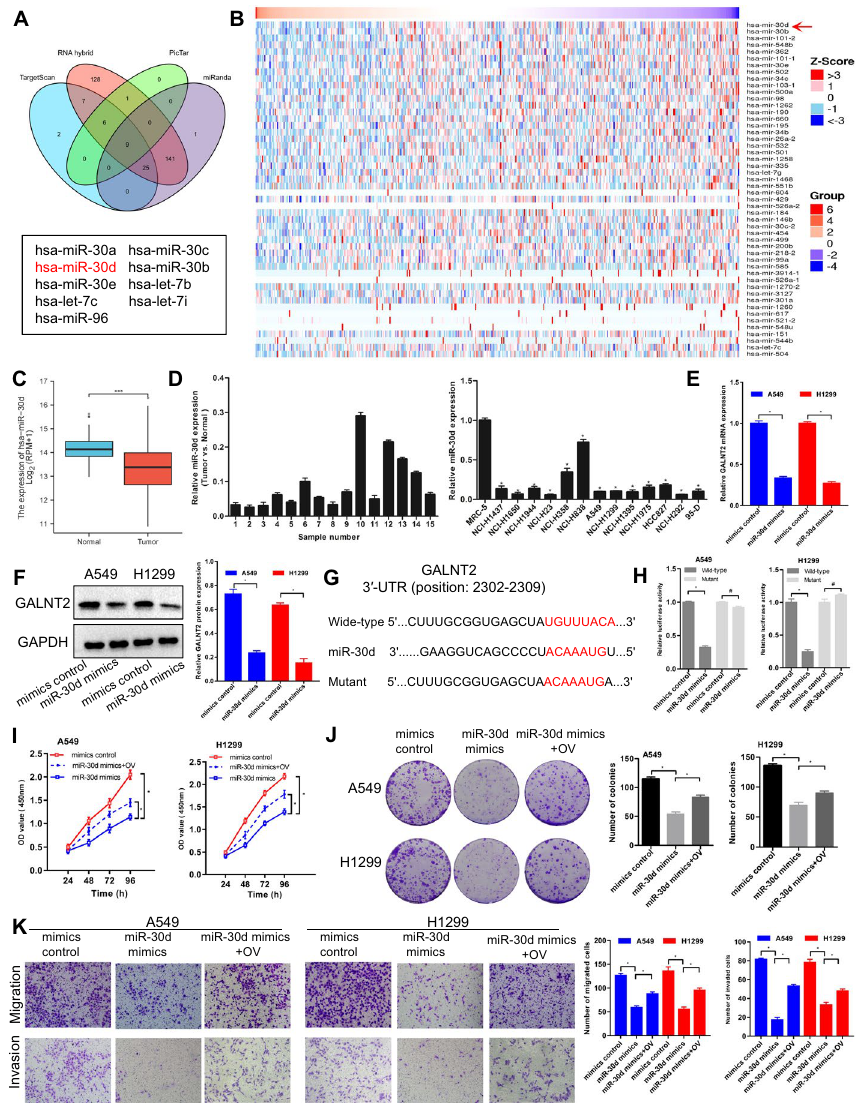
Fig. 9 miR-30d negatively regulates GALNT2 expression in NSCLC. A Four databases were employed to predict the potential miRNAs targeting GALNT2. B Heatmaps of the top 50 miRNAs negatively associated with GALNT2 in NSCLC. C Analysis of miR-30d expression in TCGA. D Analysis of miR-30d expression using cDNA microarrays. E Detection of GALNT2 expression by RT-qPCR. F Detection of GALNT2 expression by Western blot. G Schematic representation of the putative binding site for miR-30d in the GALNT2 3 ′ -UTR. H Luciferase reporter assay. I CCK-8 assay. J Colony formation assay. K Transwell migration and Matrigel invasion assays (magnification, 100). OV GALNT2 overexpression lentivirus. # P > 0.05, * P < ×